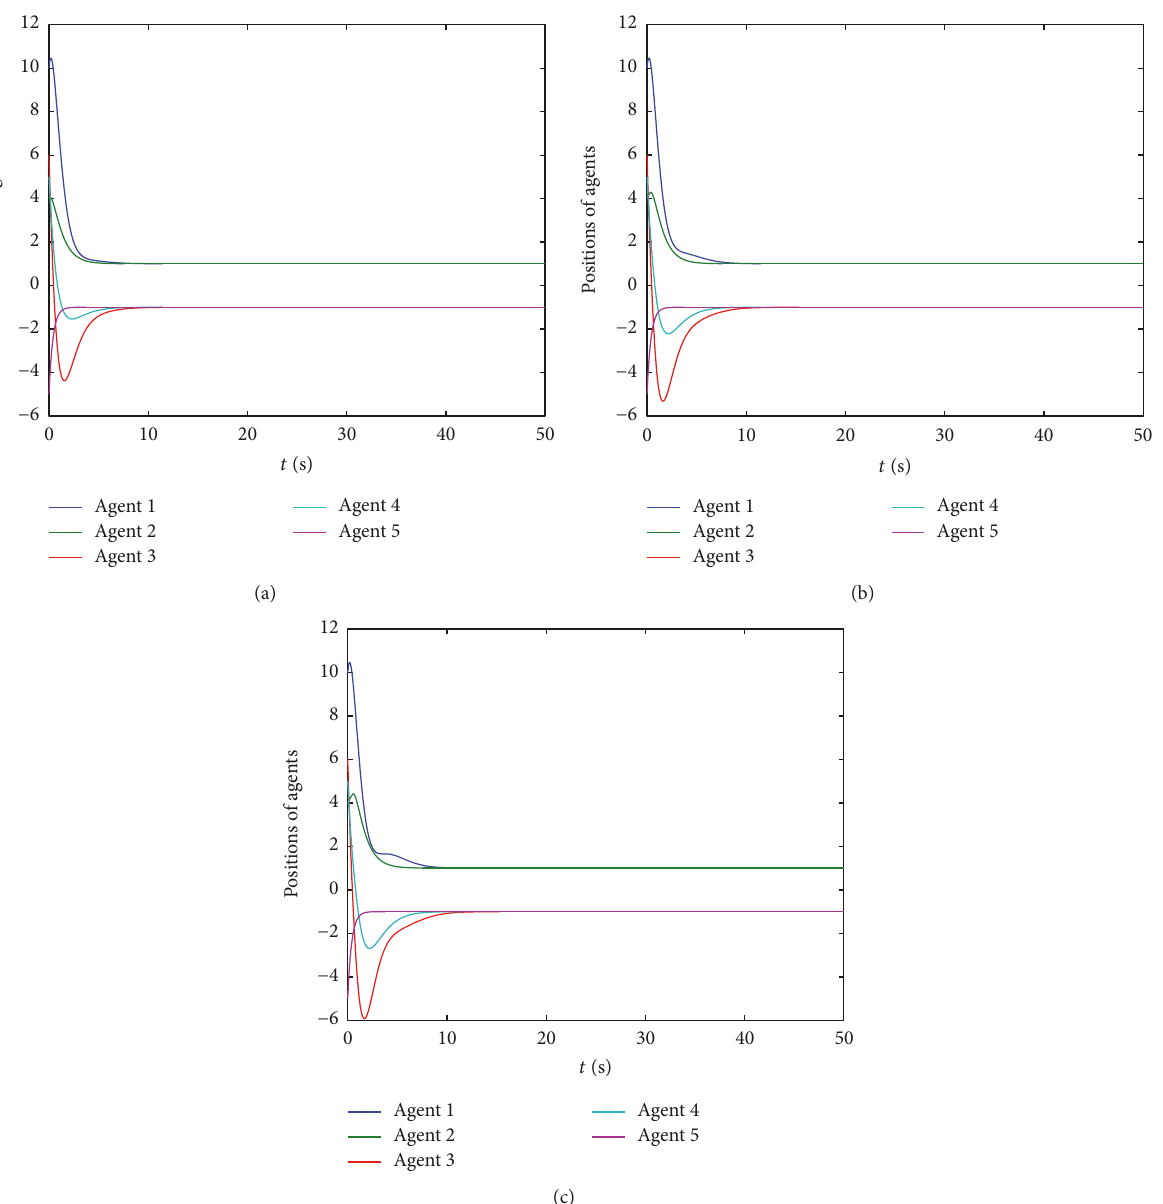
Figure 5: The state trajectories of the agents in systems (3). (a) 𝜏 𝑖𝑗 = 0 s, (b) 𝜏 𝑖𝑗 = 0.3 s, and (c) 𝜏 𝑖𝑗 = 0.5